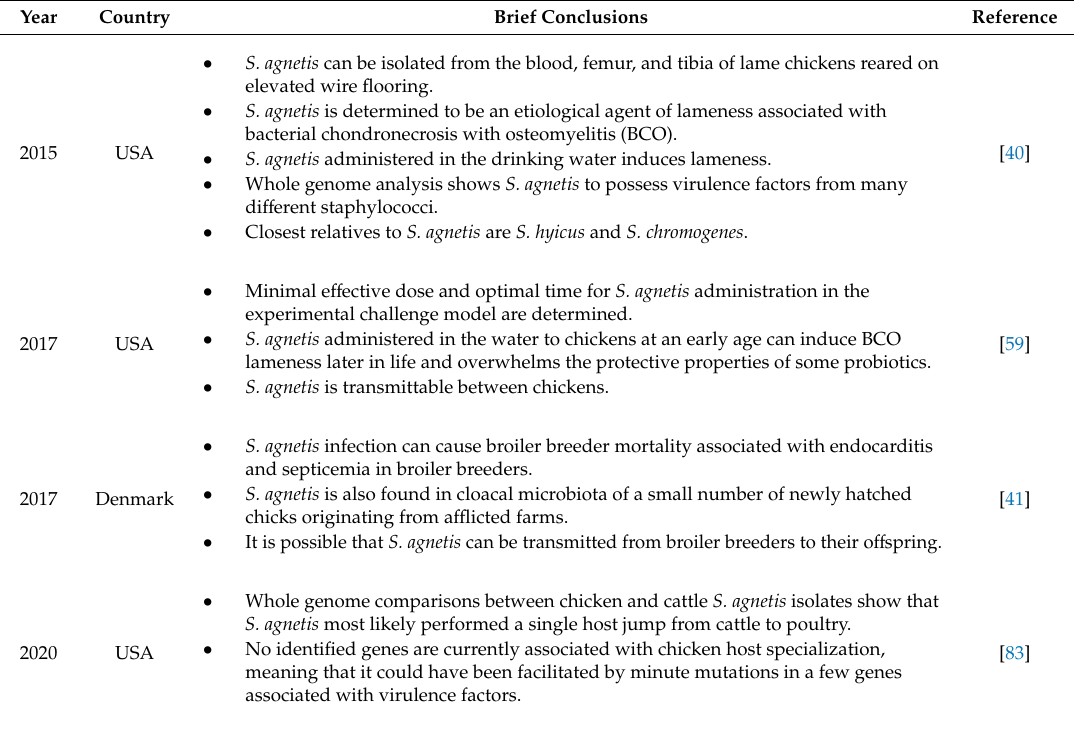
Table 3. A summary of current studies of Staphylococcus agnetis in